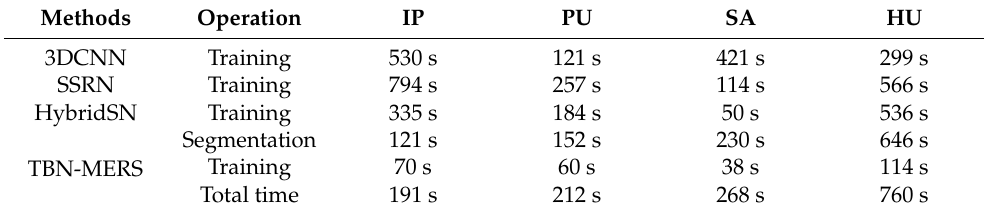
Table 14. Time for deep learning methods on different